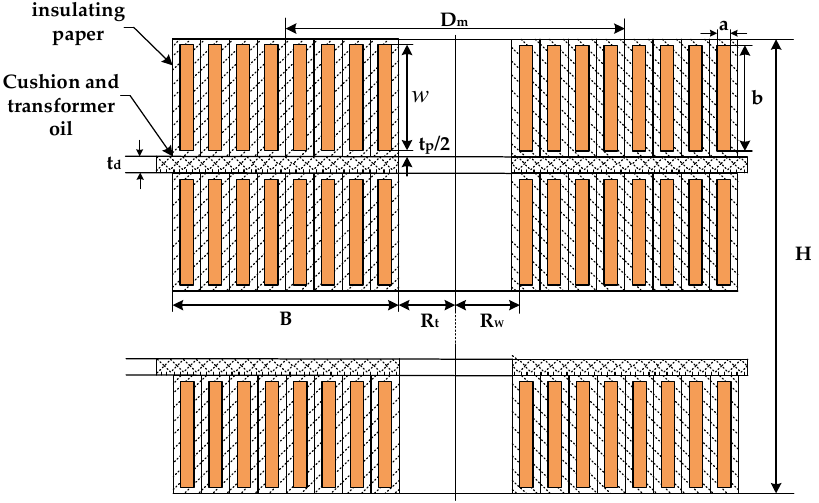
Figure 8. Insulation diagram between cakes.